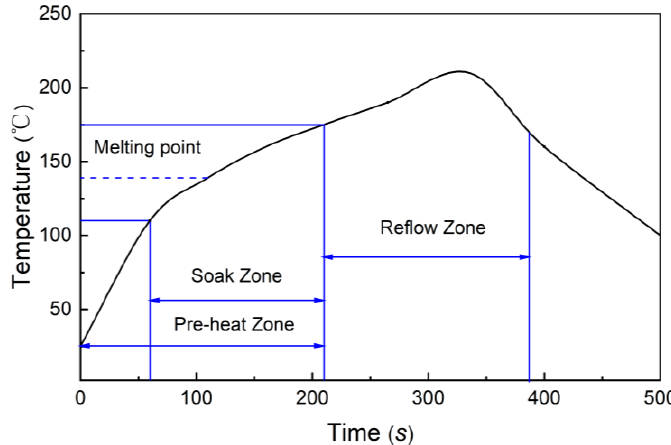
Figure 1. Reflow profile of solder paste.